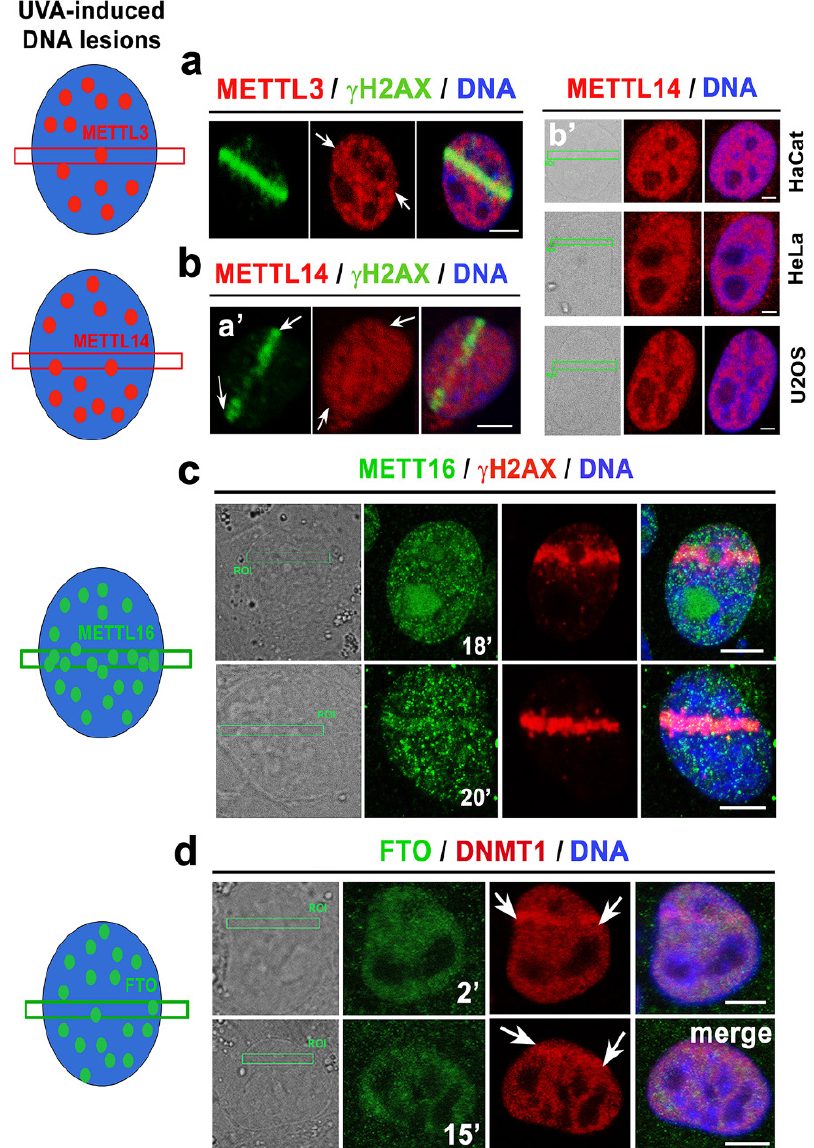
Figure 5. Microirradiation did not affect METTL3/METTL14 and FTO levels, while the METTL16 protein recruits to locally microirradiated chromatin in a subset of irradiated cells. Levels of ( a ) METTL3 in MEF, ( b ) METTL14 in a’ MEF, and b’ HaCaT, HeLa, U2OS cells locally irradiated by UVA laser. ( c ) The level of METTL16 in microirradiated MEFs, and ( d ) the distribution pattern of the FTO protein in the microirradiated chromatin of MEFs. The nuclear distribution pattern of METTL3 / METTL14 and FTO proteins was not significantly changed by local laser microirradiation, but METTL16 was recruited to microirradiated chromatin in 10% of cells (see lower micrographs in panel ( c )). Scale bars represent 10 μ m.